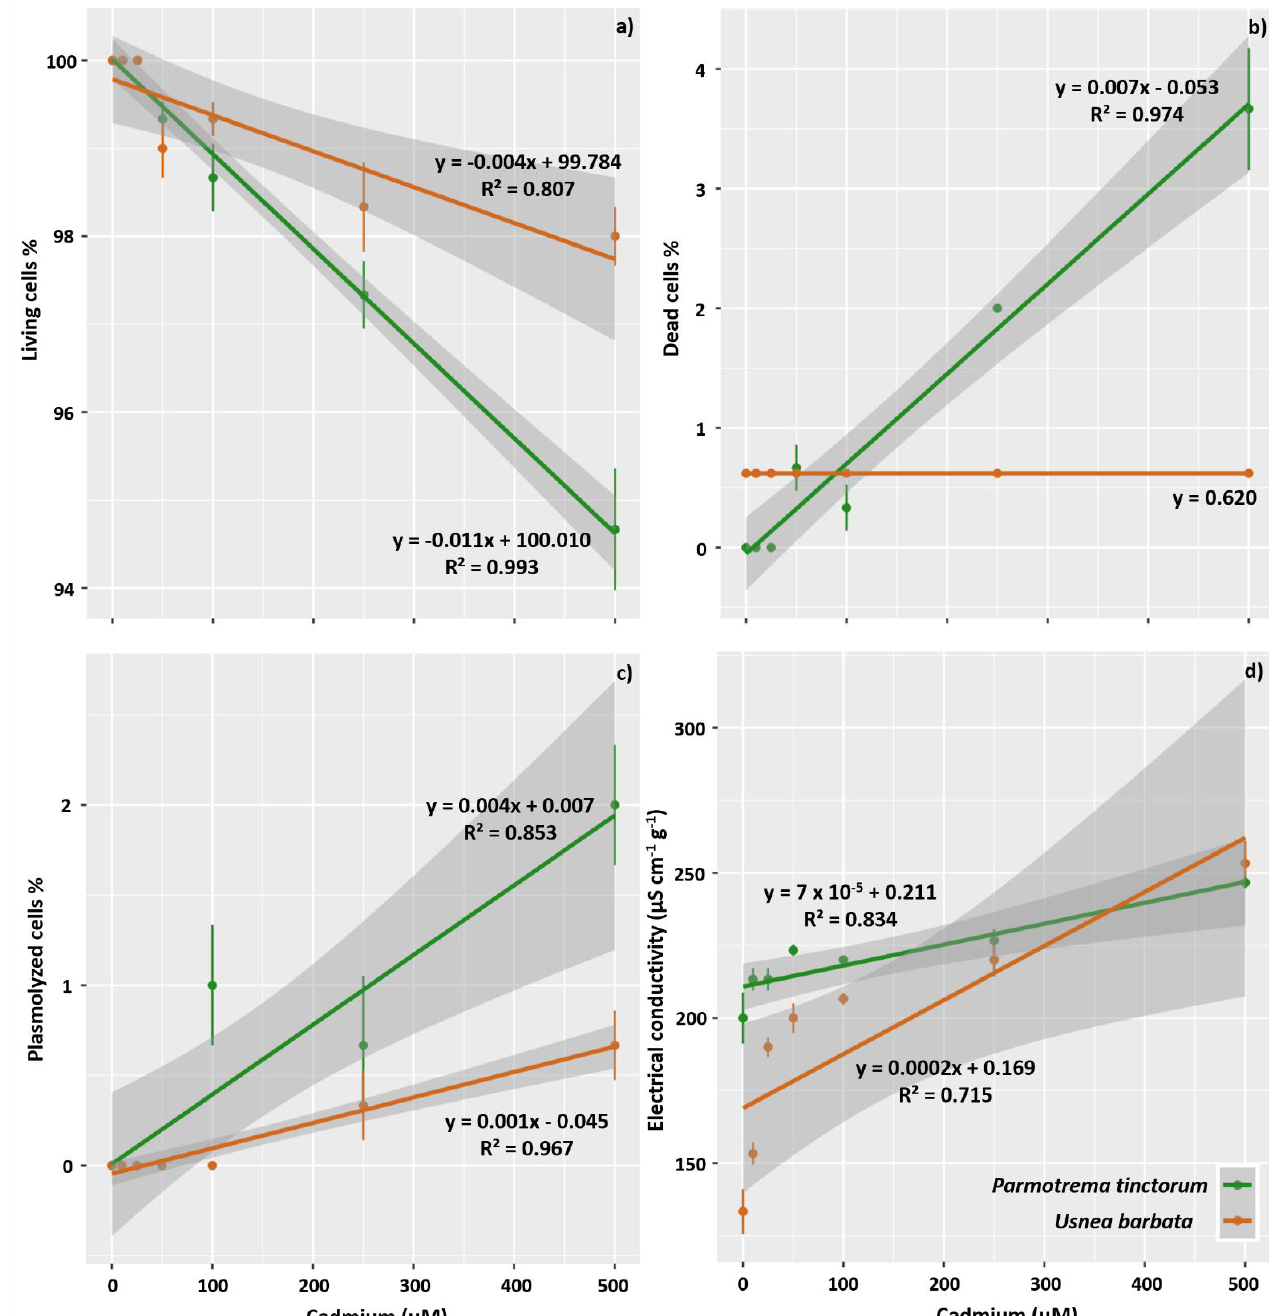
Figure 1. Percentage of living ( a ), dead ( b ), and plasmolyzed ( c ) cells observed for the photobiont, and electrical conductivity ( d ) observed for the thalli, of the lichen species Parmotrema tinctorum and Usnea barbata subjected to different concentrations of the heavy metal cadmium (0, 10, 25, 50, 100, 250, and 500 µM). The straight lines represent the fitted model, and the prediction intervals (95%) are in gray.